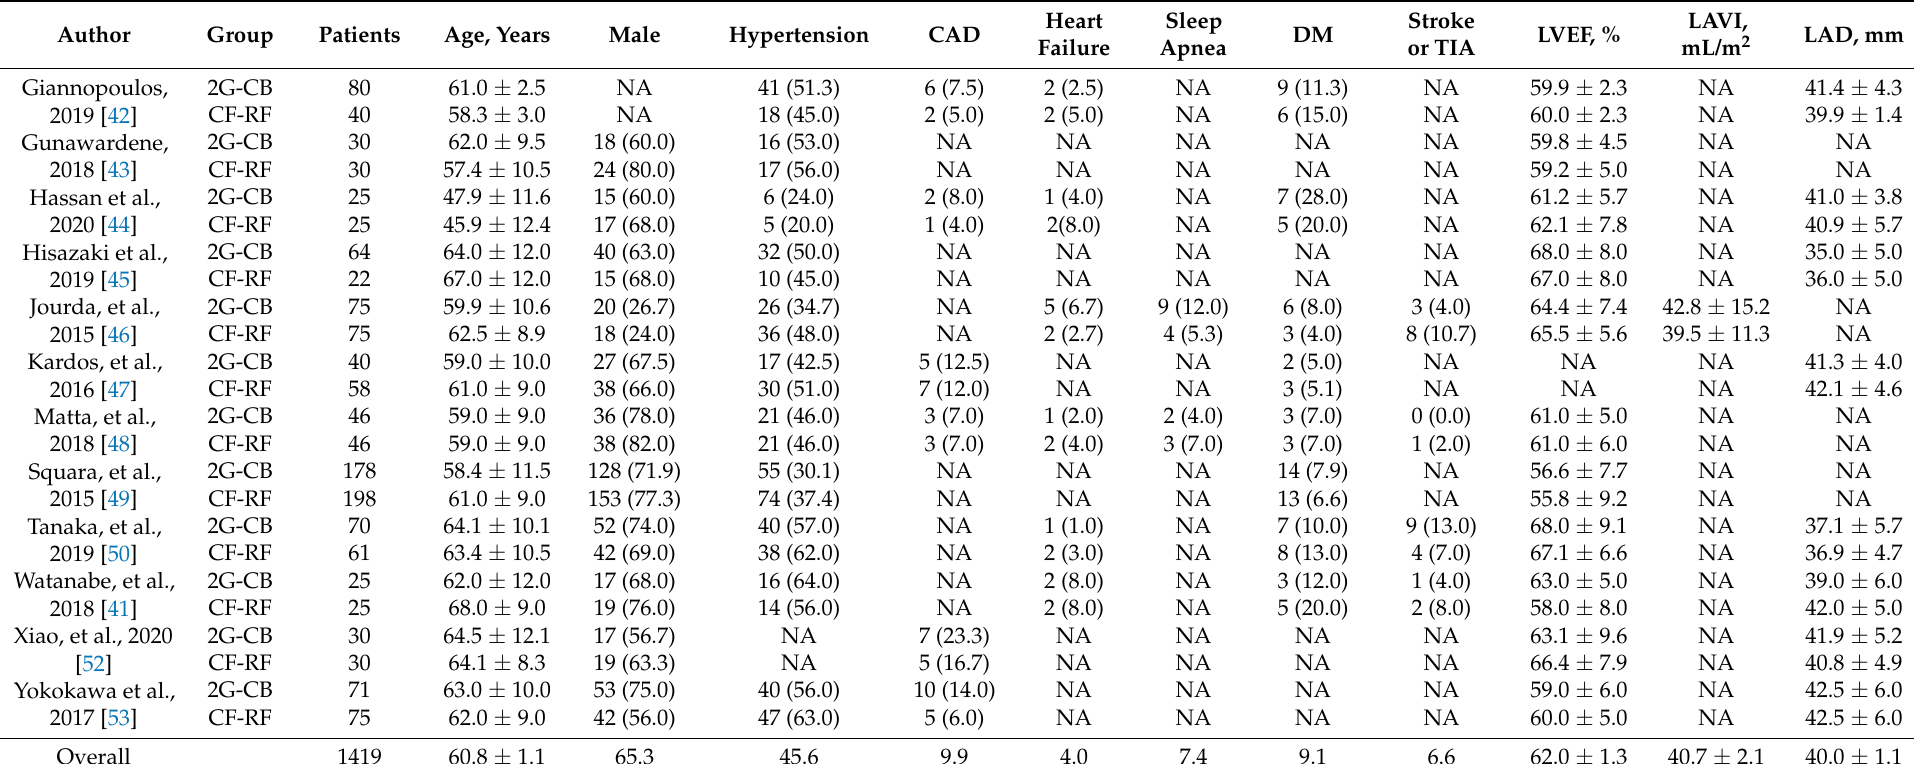
Table 2. Baseline characteristics of the patients from the involved